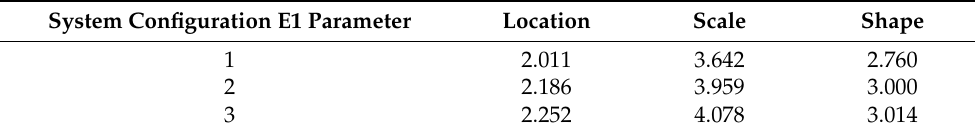
Table 1. Erlang distribution parameters, describing the time t S 2 , depending on the experience of the first operator.